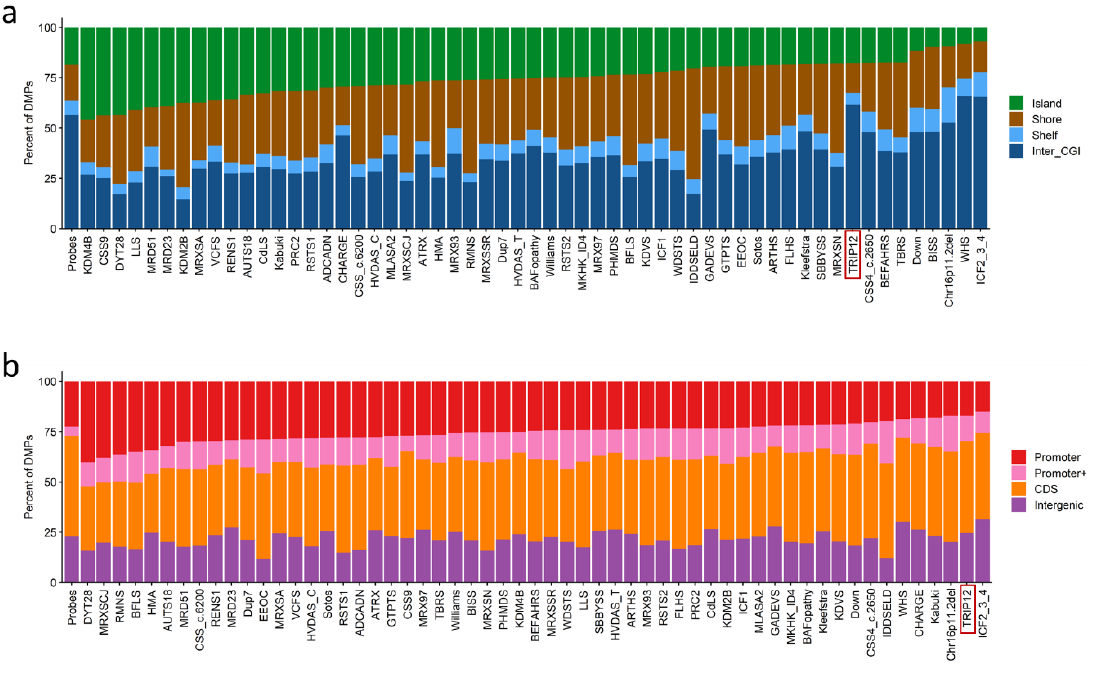
Figure 7. Differentially methylated probes (DMPs) annotated in the context of CpG islands and